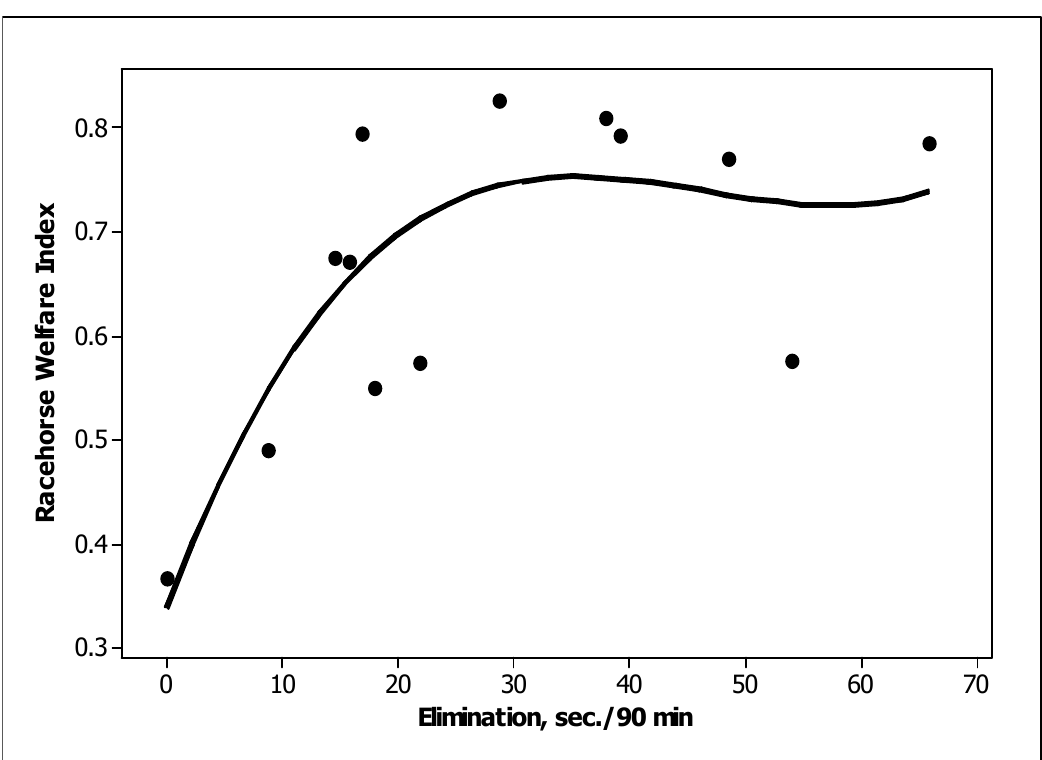
Figure 3. Positive relationship between startle time and the TBRWI score.